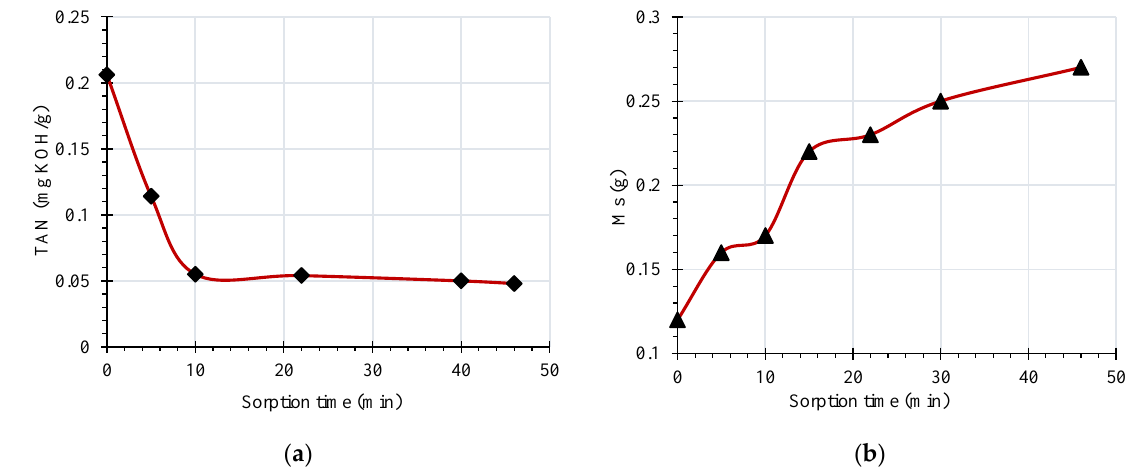
Figure 5. Illustration of TAN and mass of membrane as a function of sorption time. ( a ) Variation of TAN with sorption time. ( b ) Variation of the mass of RC with sorption time.